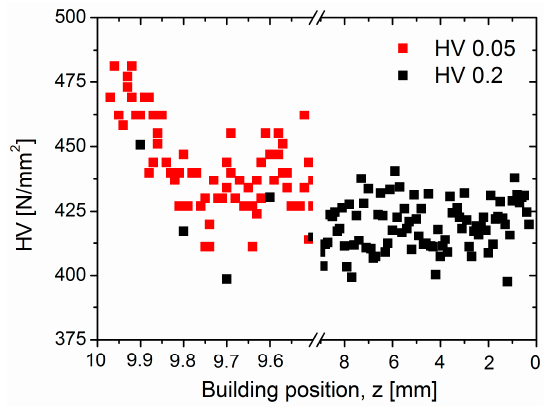
Figure 3. Vickers microhardness as a function of the SLM building position, z , with top and bottom of the sample z = 0 mm and z = 10 mm, respectively (as in Figure 1).